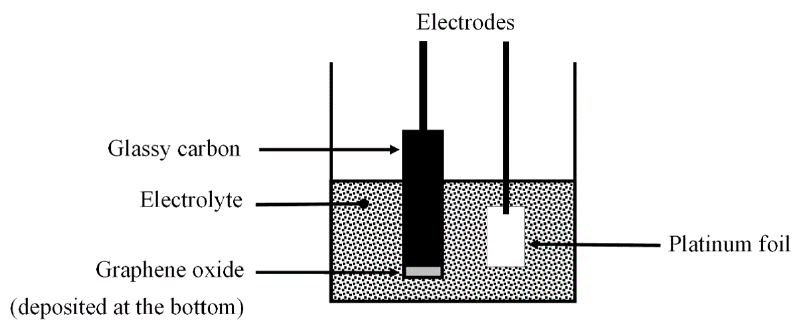
Figure 8: Electrochemical cell for extracting graphene oxide from bulk glassy carbon (Nasibulina et al .,